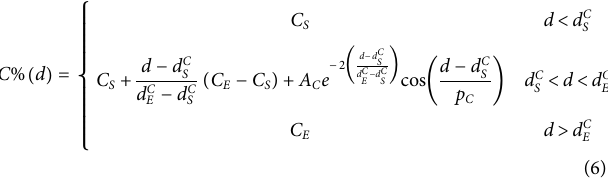
Frontiers in Physics |